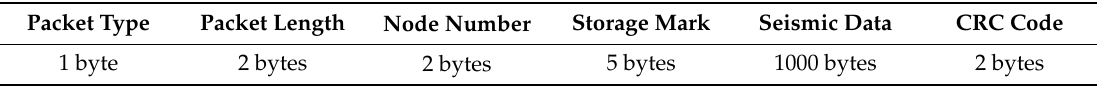
Table 2. Seismic data packet